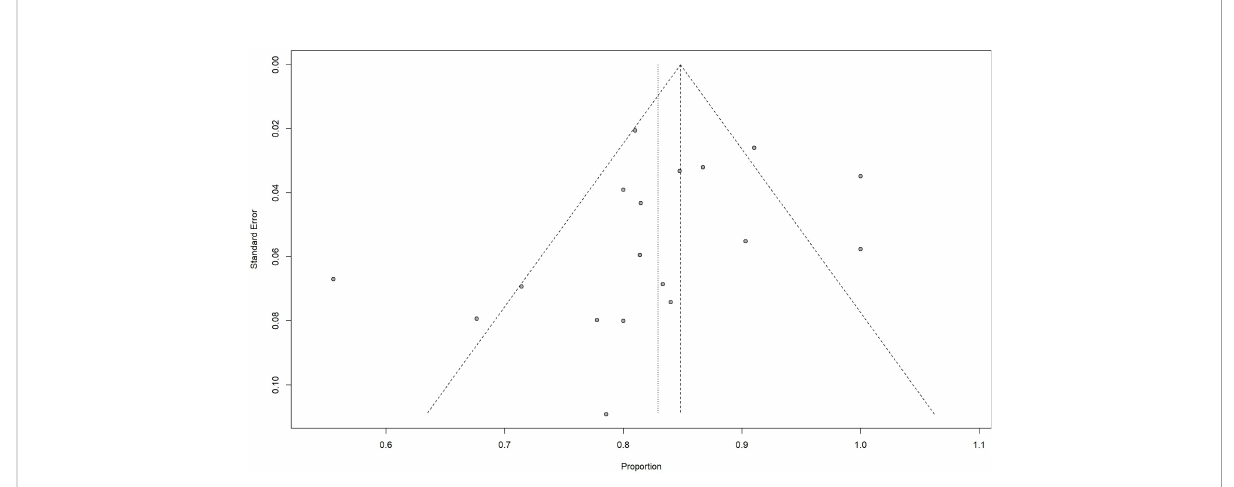
FIGURE 3 Funnel plot of 2-year OS